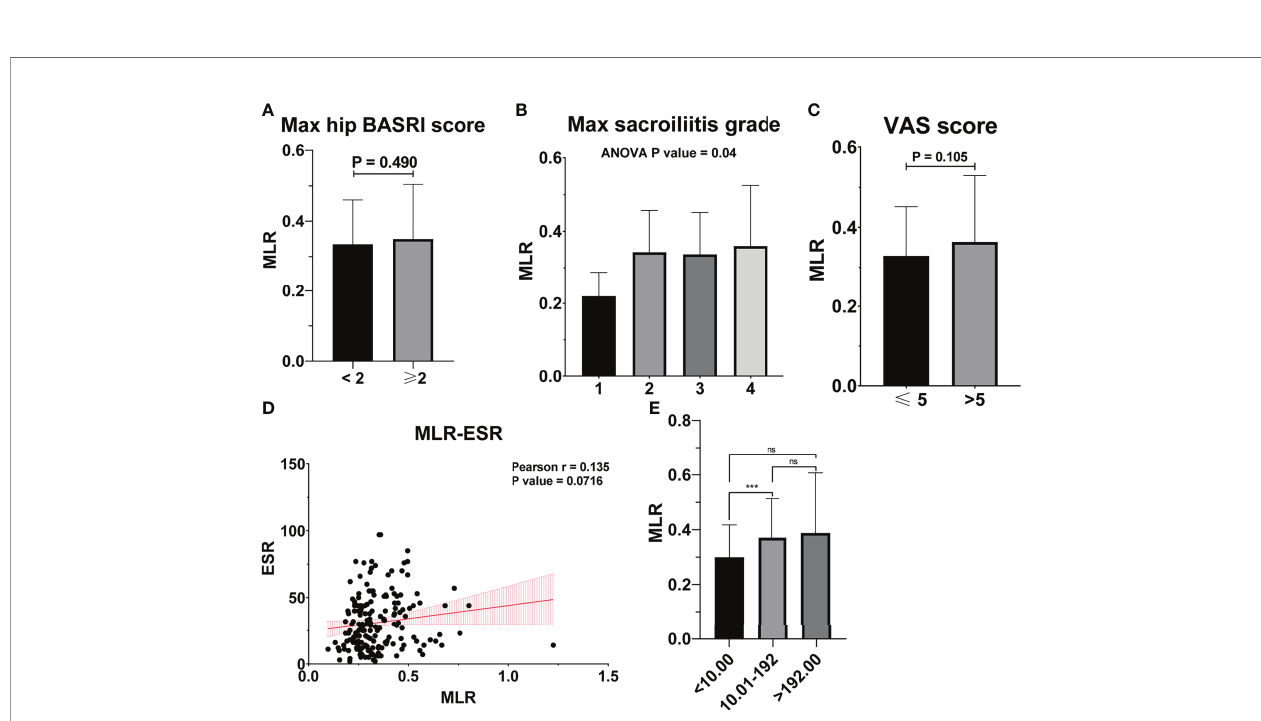
FIGURE 5 | MLR is not associated with the severity of AS. (A) MLR between AS patients with max hip BASRI socre < 2 and ≥ 2. (B) MLR in AS patients with different max sacroiliitis grade. (C) MLR between AS patients with different VAS pain score. (D) The correlation of MLR with ESR. (E) MLR between AS patients with different CRP group. *** representative p value < 0.001; ns representative p value >